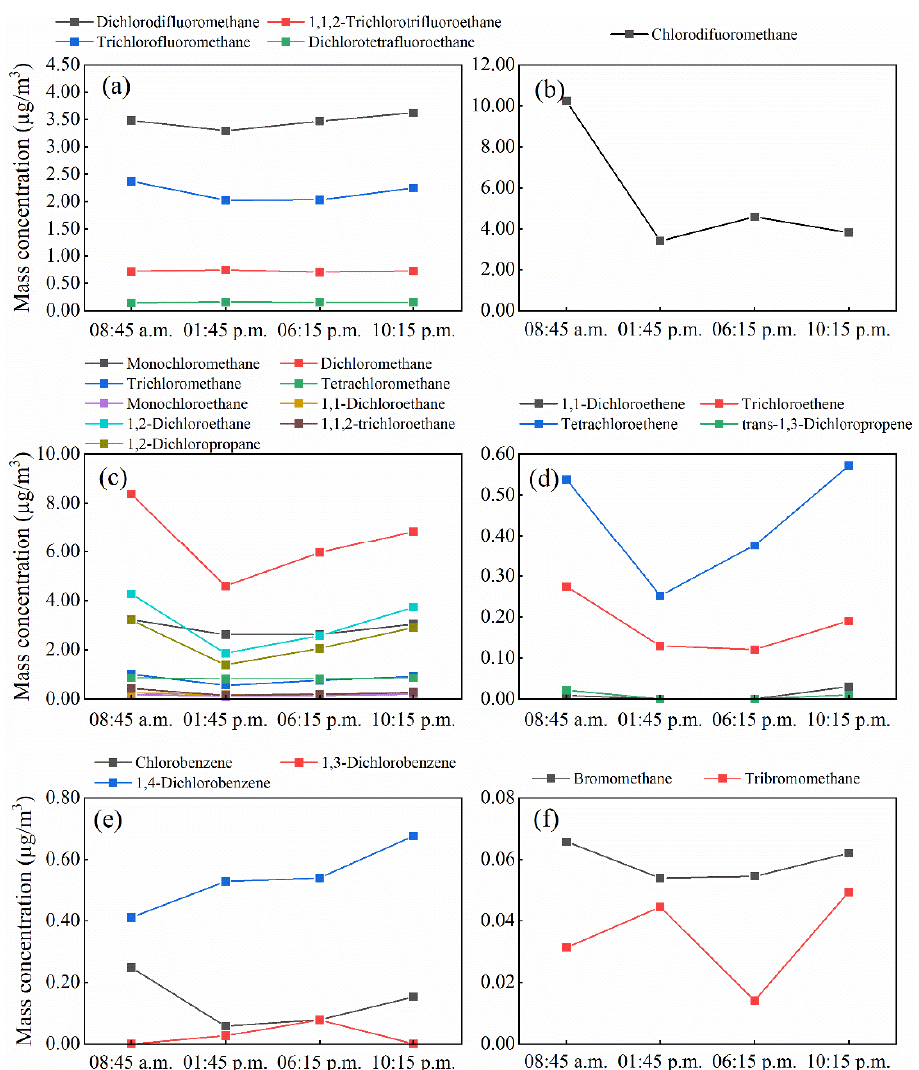
Figure 8. Diurnal variation in average mass concentration of selected volatile halogenated halocarbons. ( a ): chlorofluorocarbons; ( b ): hydrochlorofluorocarbon; ( c ): chloroalkanes; ( d ): chloroalkenes; ( e ): chlorinated benzenes; ( f ): bromohydrocarbons.